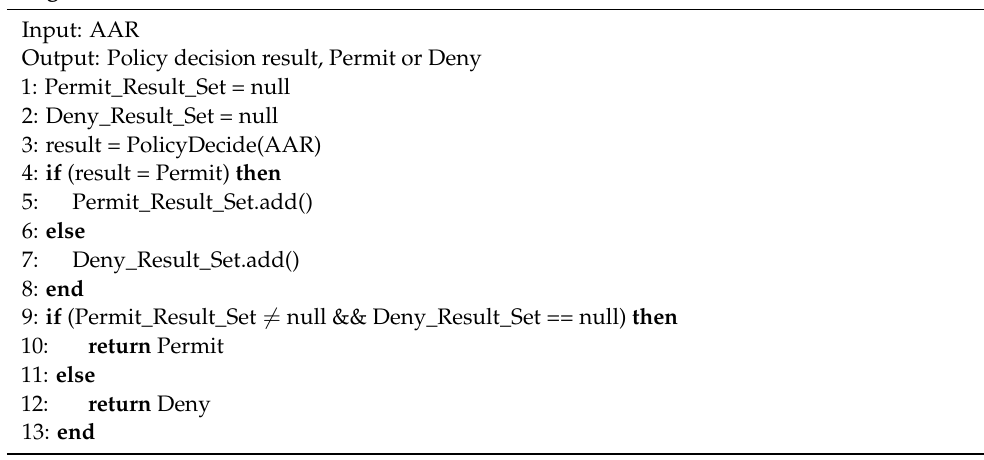
Algorithm 1 Permission decision